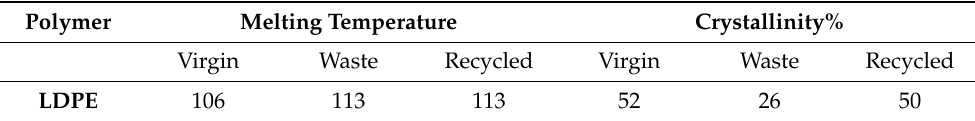
Table 12. Melting temperature and crystallinity of virgin, waste and recycled LDPE studied